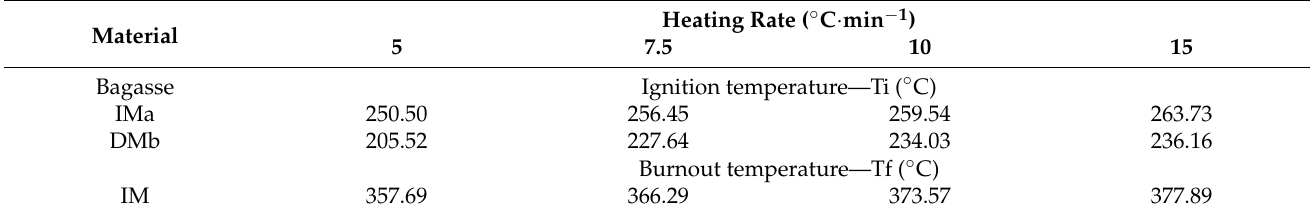
Table 2. Ignition and burnout temperatures of sugarcane bagasse at four heating rates.